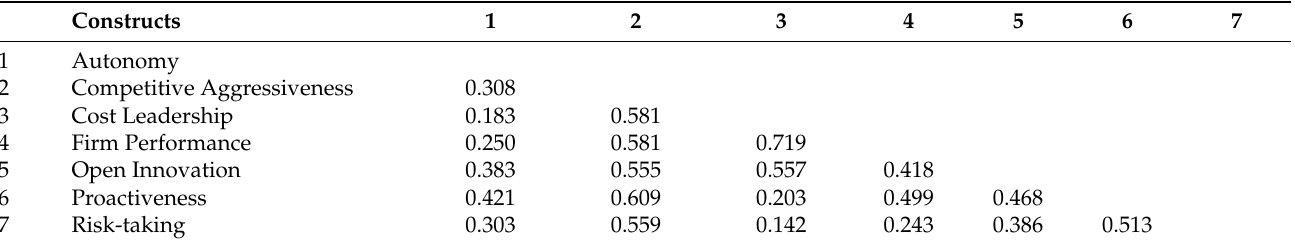
Table 5. Discriminant Validity (HTMT).